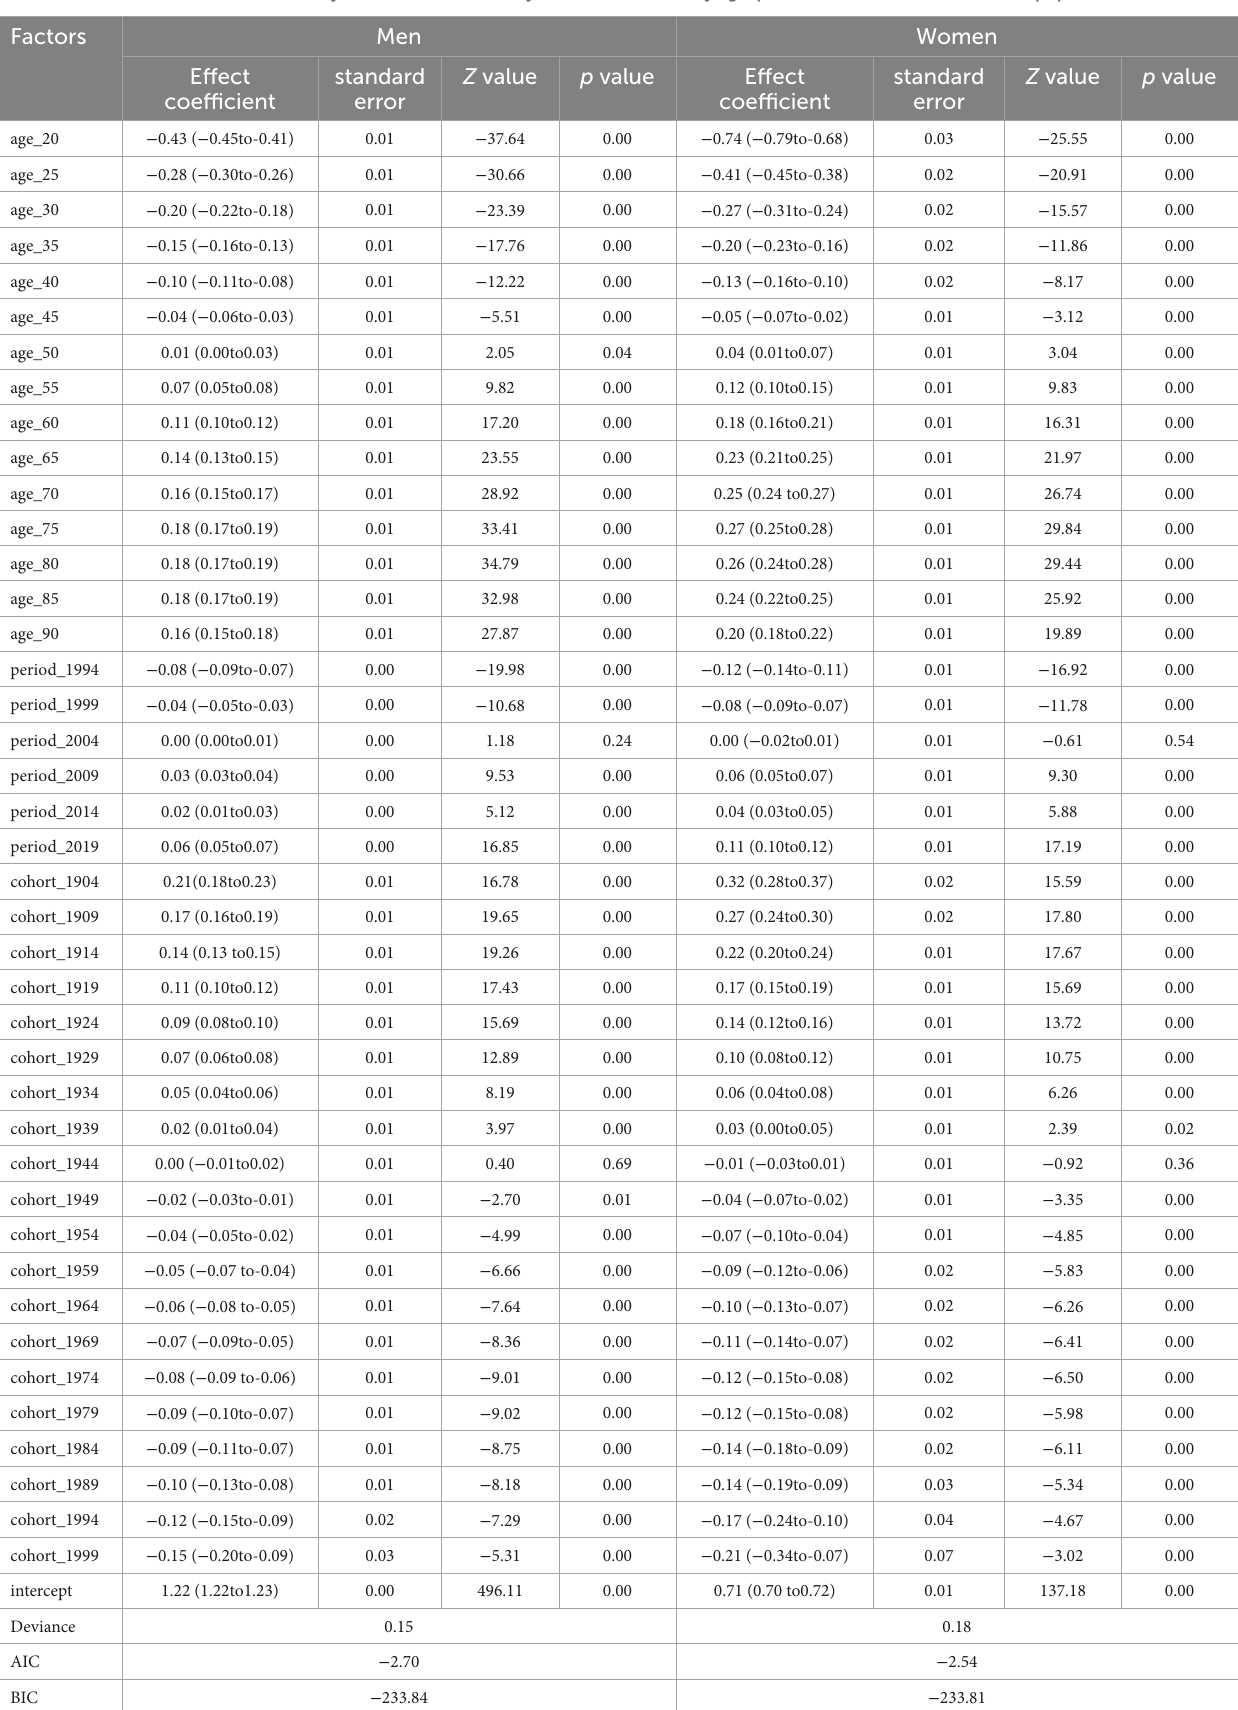
TABLE 3 Relative risk and 95% CI for the years lived with disability of edentulousness by age, period, and cohort in the Chinese population. Factors Men Women Effect coefficient